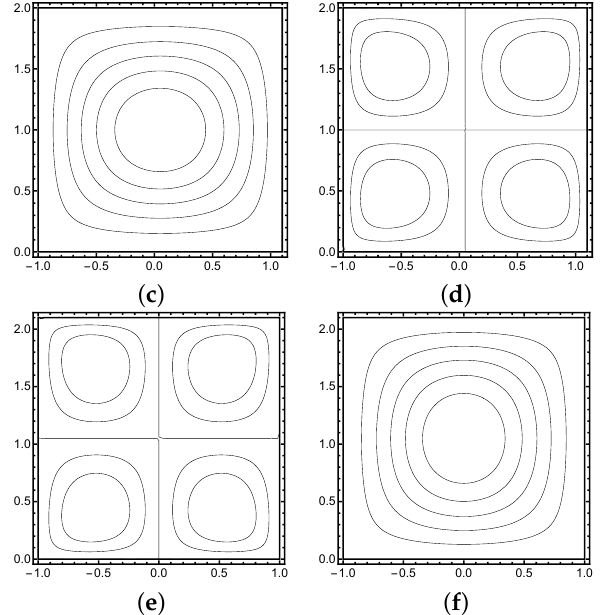
Figure 1. Effect of the perturbation of the computational domain on the smallest eigenmode. In the symmetric case, the components of the two modes of the cluster are interchanged reflections. Axial perturbation of the domain selects predictably the single smallest mode. In all three cases, the two modes are indicated as u 1 = { u 1 , u 2 } , u 2 = { v 1 , v 2 } . ( a ) Domain: [ − 1,1 ] × [ 0,2 ] ; u 1 , v 2 ; ( b ) v 1 , u 2 ; ( c ) Domain: [ − 1,11/10 ] × [ 0,2 ] ; ˆ u 1 ; ( d ) ˆ v 1 ; ( e ) Domain: [ − 1,1 ] × [ 0,21/10 ] ; ˜ u 1 ; ( f ) ˜ v 1